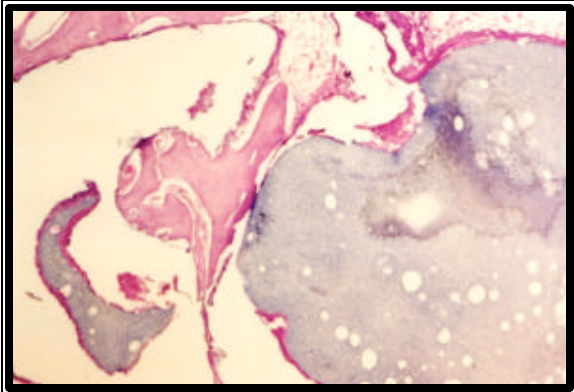
FIGURA 3 - Fotomicrografia óptica do implante de cimento de fosfato de cálcio, implantado no rádio de coelhos com a seta maior mostrando a desmineralização do material. A seta menor mostra o envolvimento do material por tecido conjuntivo aumento de 4x, tempo pós-operatório 12